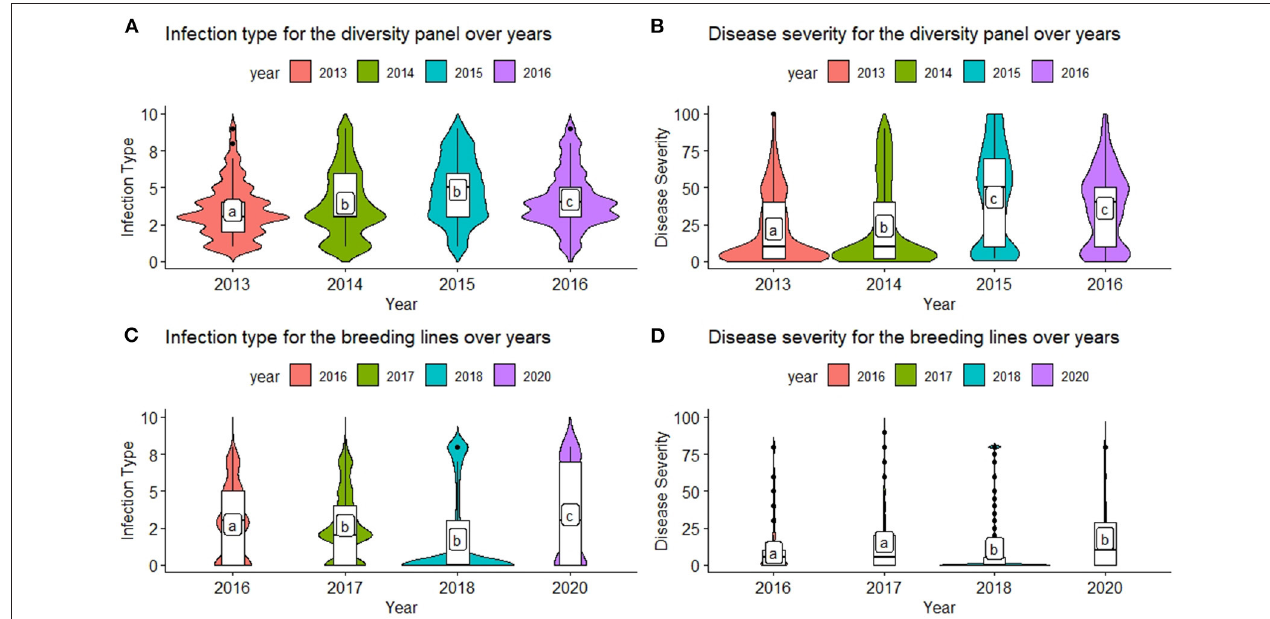
FIGURE 1 | Comparison of infection type (IT) and disease severity (SEV) over years in the diversity panel (DP) lines and breeding lines (BL) training populations using least significant differences. Models labeled with the same letter are not significantly different ( p = 0.05). (A) Infection type for the diversity panel over years. (B) Disease severity for the diversity panel over years. (C) Infection type for the breeding lines over years. (D) Disease severity for the breeding lines over